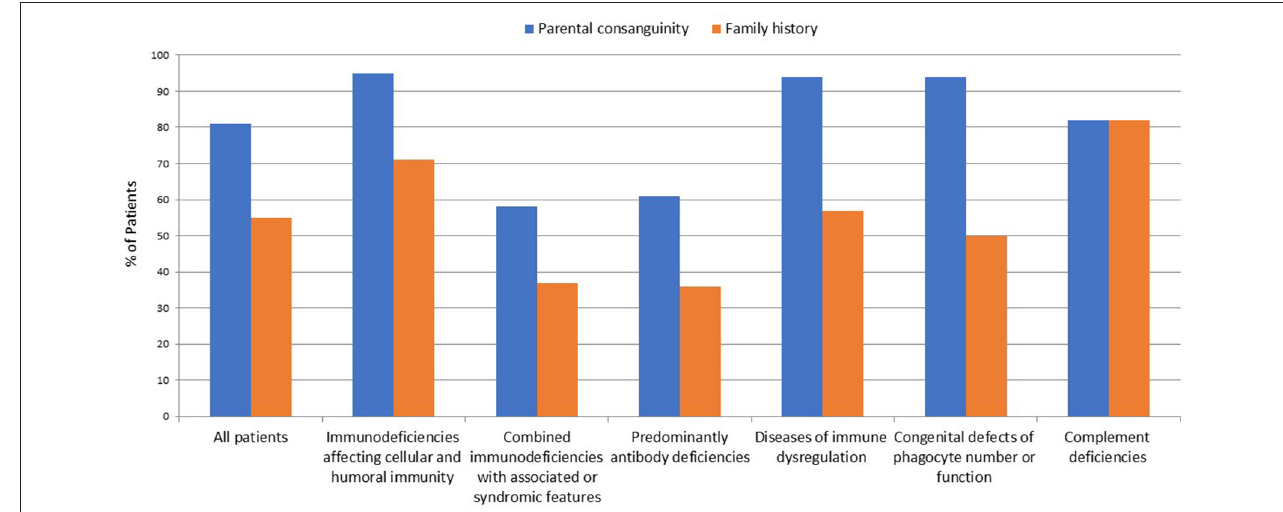
FIGURE 1 | Frequency of parental consanguinity and family history among 264 patients registered in KNPIDR.